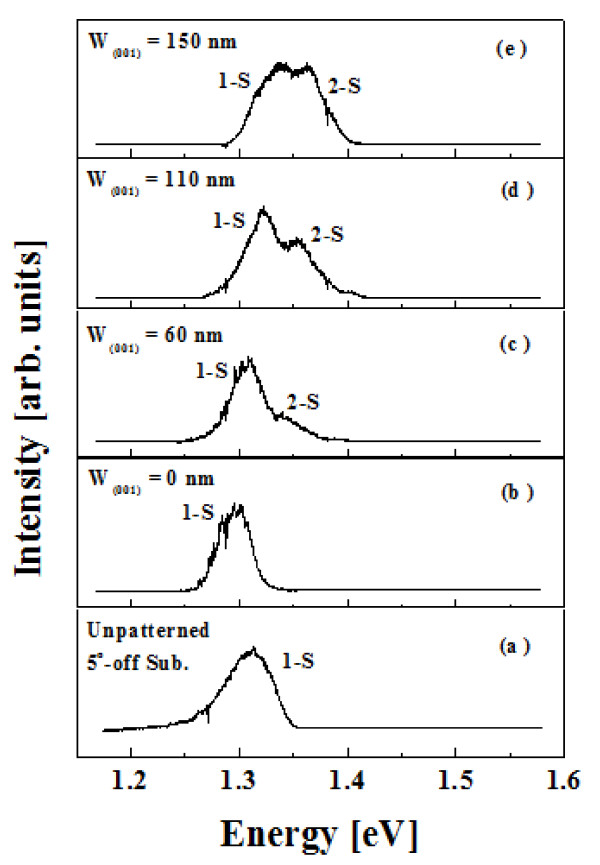
(a) The μ-PL spectrum of In0.8Ga0.2As SAQDs grown on unpatterned 5°-off (001) GaAs substrates and μ-PL spectra at 4.0 K of the In0.8Ga0.2As SAQDs ensemble grown on SiO2-patterned 5°-off (001) GaAs substrates with W(001) of (b) 0, (c) 60, (d) 110, and (e) 150 nm, respectively.